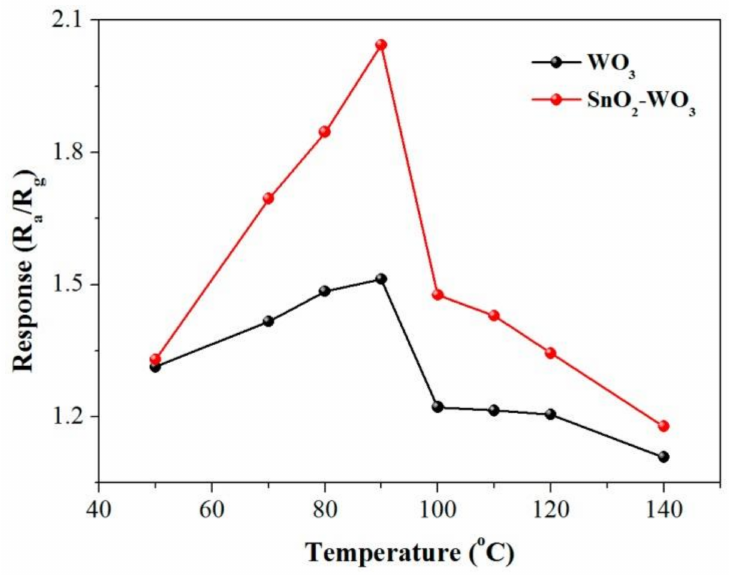
Figure 11. Gas response of pure tungsten trioxide and SnO 2 -doped WO 3 towards 500 ppm of CH 4 at various working temperatures. Reprinted with permission from reference [80] under CC license.